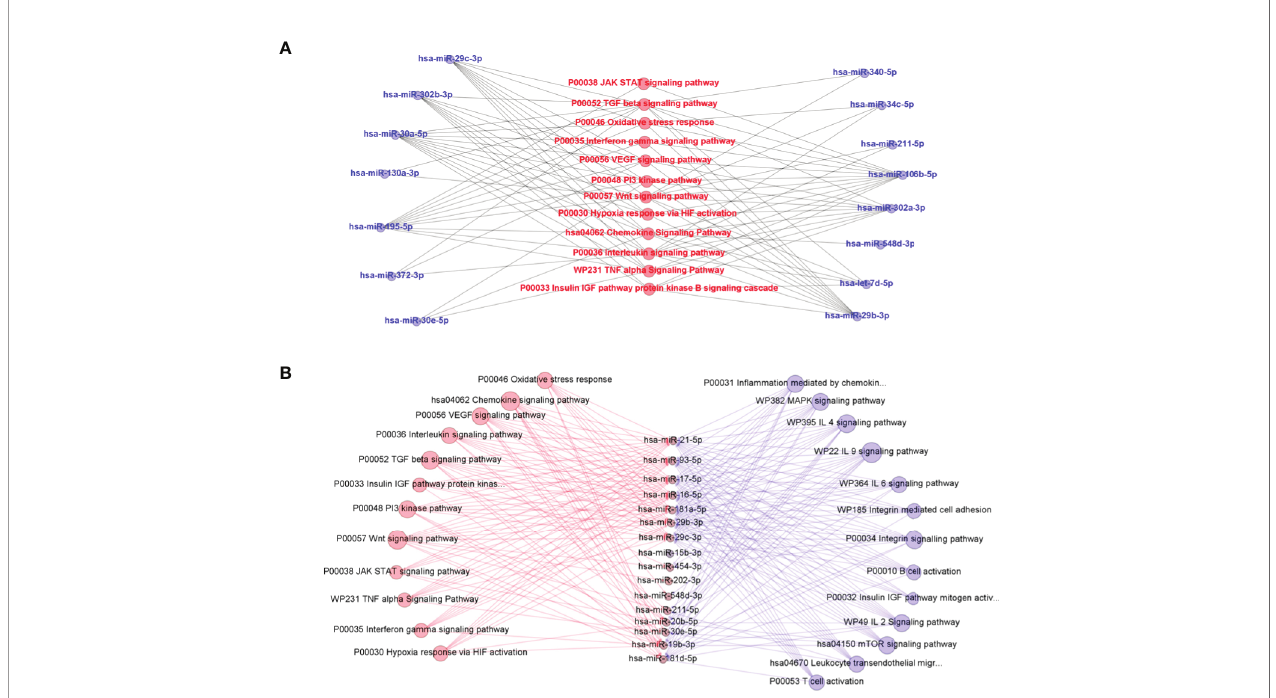
FIGURE 5 | Predicted interactions between the set of differentially expressed microRNAs in THP-1 cells after 6 and 24 h post infection with L. braziliensis (A) and in plasma samples from self-healed patients compared to active disease individuals (B) and the biological pathways related to in fl ammatory response on which they are suggested to act according to MiEAA algorithms. In (B) , pathways in red were predictably targeted by in vitro and ex vivo miRNA sets, while the others in blue were evidenced only in miRNAs signi fi cantly quanti fi ed in